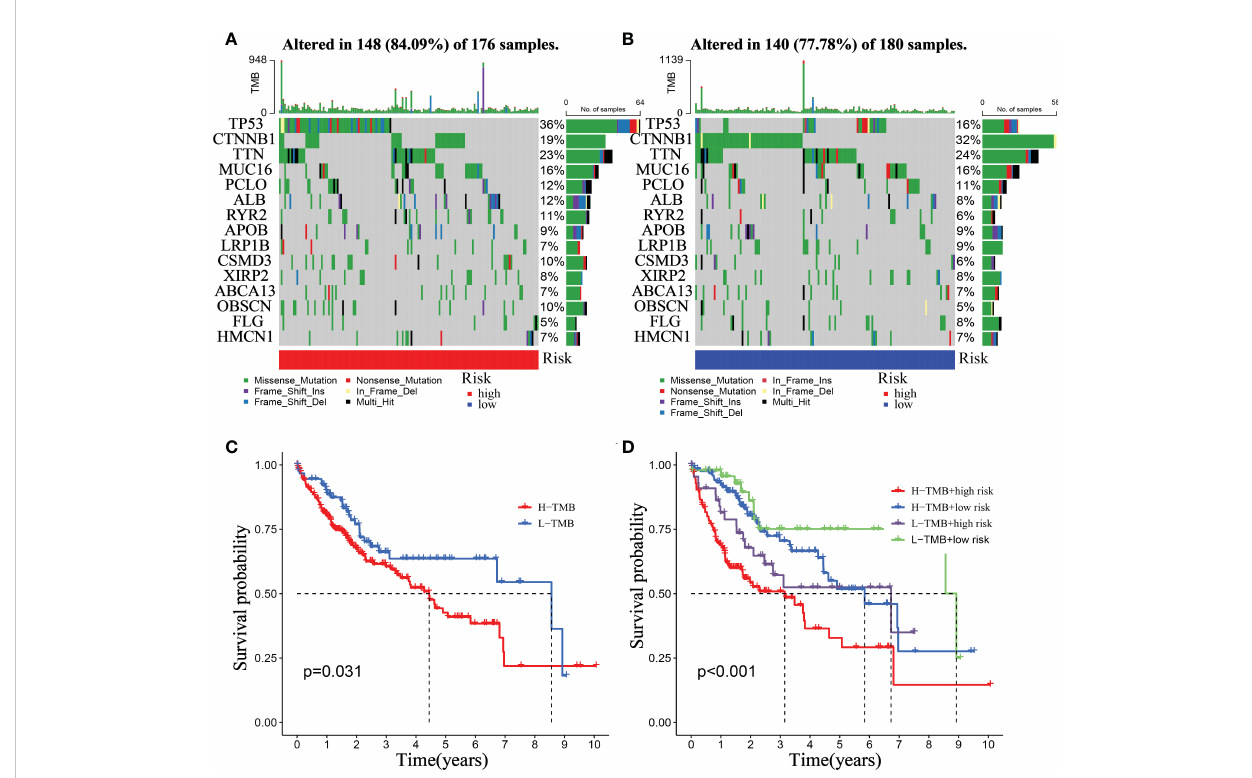
FIGURE 12 Relationship between the mitophagy-Related Signature and somatic mutation. Waterfall plots of 30 genes with the highest mutation rate in the high-risk group (A) and the low-risk group (B) . (C) Kaplan – Meier analysis of TMB in HCC patients. (D) Kaplan – Meier analysis of the correlation between riskScore and